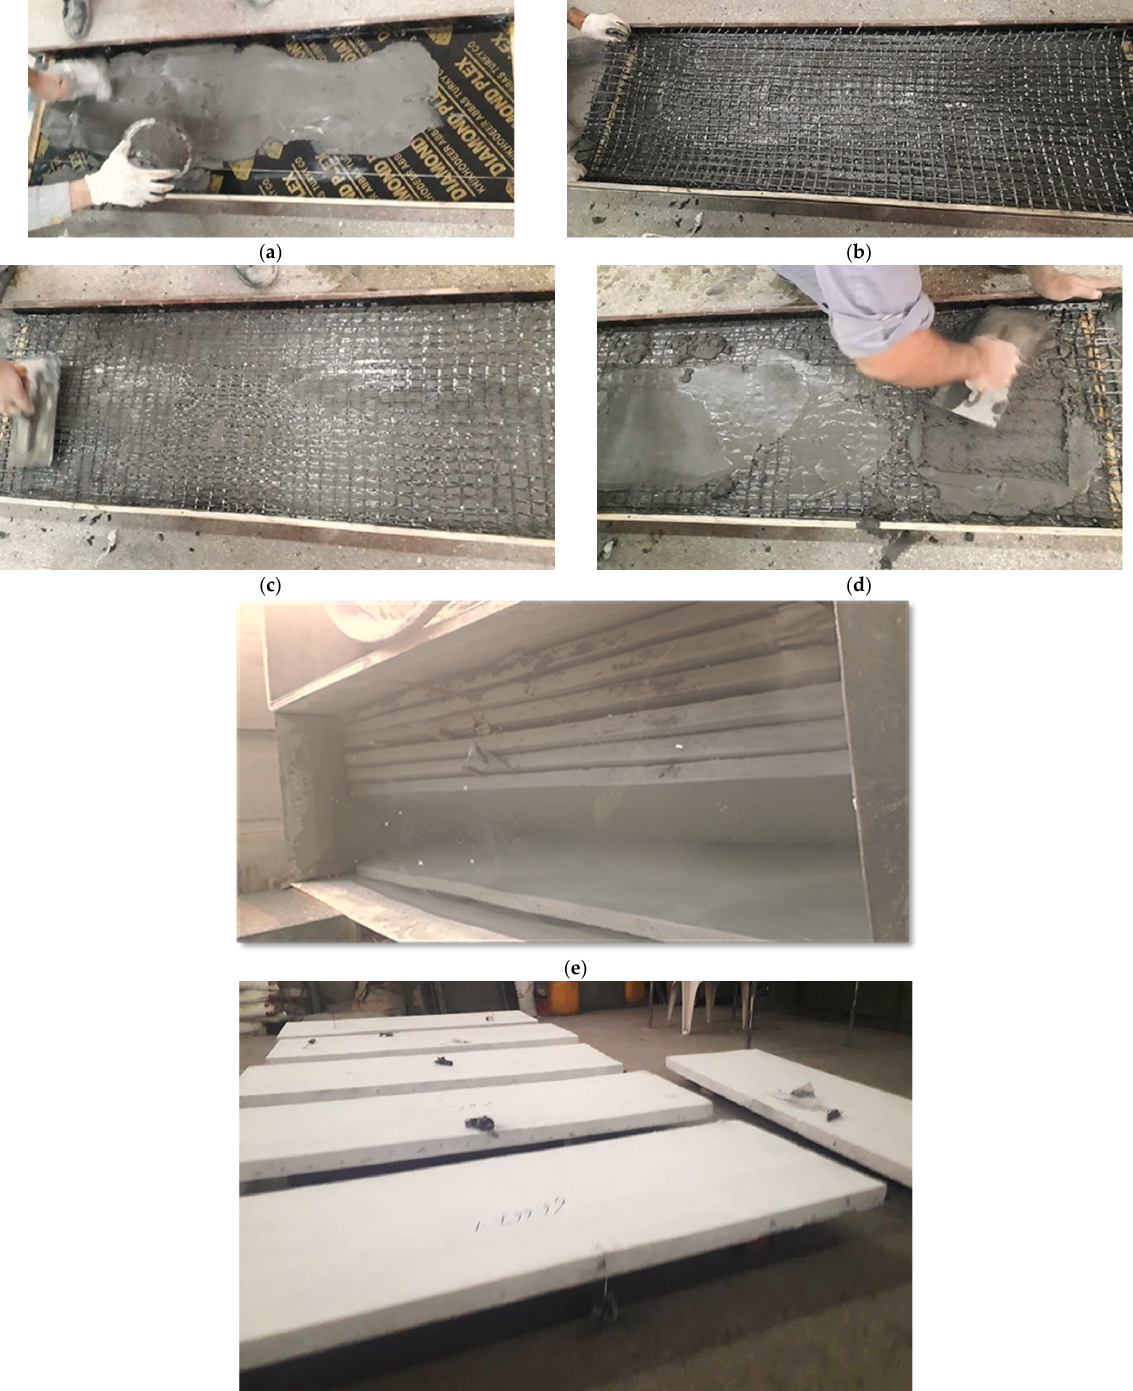
Figure 4. The slab specimens during the casting, curing, and painting processes. ( a ) Casting of concrete cover. ( b ) Placing of textile layer. ( c ) Pressing the textile layer ( d ) Top concrete casting. ( e ) Curing of slabs by immersing in water tank. ( f ) Finished view of slabs after